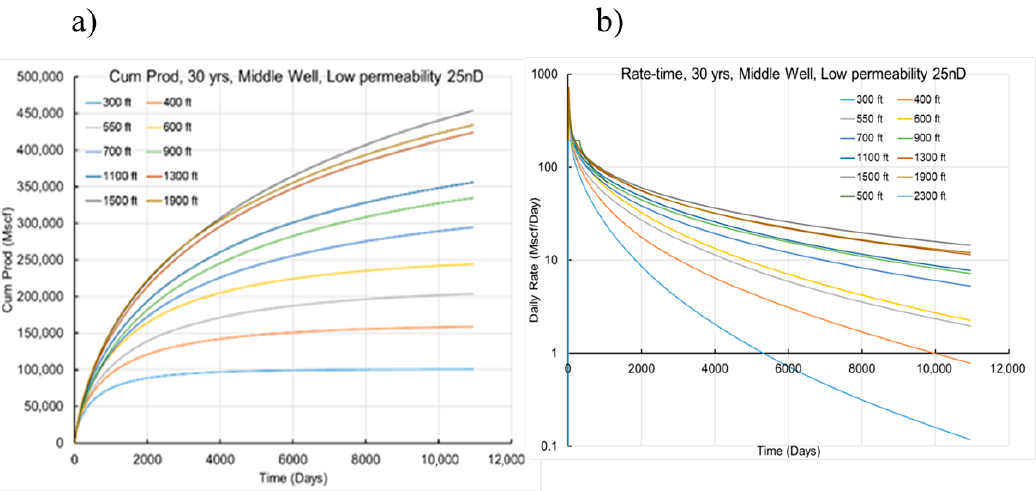
Figure A2. Production performance of Utica wells for fracture spacing ranging between 220 and 18.3 ft. The base case performance is for the Utica type well with 55 ft fracture spacing. The impact of wider and narrower fracture spacing on well productivity is graphed for both ( a ) the cumulative, and ( b ) daily production rates. Well performance curves were generated with a numerical reservoir simulator by ResFrac (data from Reference [13]).